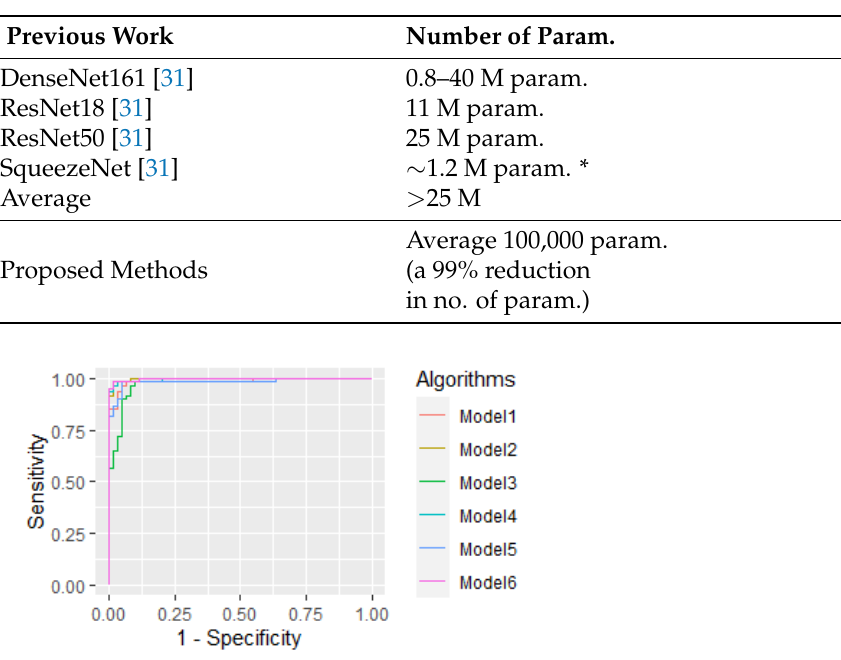
Table 9. The experimental results on the COVID-19 data set from the literature. A number of different ultra-deep CNNs were used to classify COVID patients from non-COVID people. The performance is summarized below. * Minaee et al.disclosed that SqueezeNet has approximately 50 times fewer parameters than AlexNet. The proposed architecture achieves AUC values ranging from 98% to 99.8%. For details, please refer to Figure 8 and Table 10. The average number of parameters of the ultra-deep CNNs can exceed 25 million parameters with a top AUC value of 99.2%. The proposed method has an average number of parameters of less than 100,000 with a top AUC valu of 99.8%. This is a 99% reduction in th number of parameters without sacrificing prediction performance.